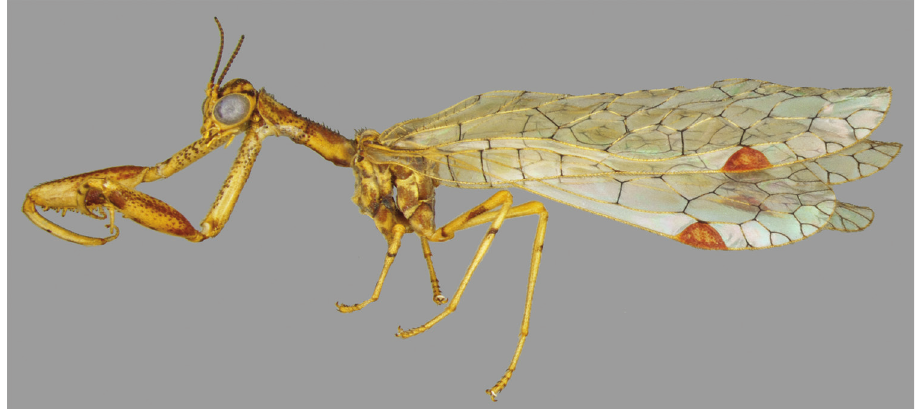
Figure 1. Habitus of a male of Nolima victor (abdomen